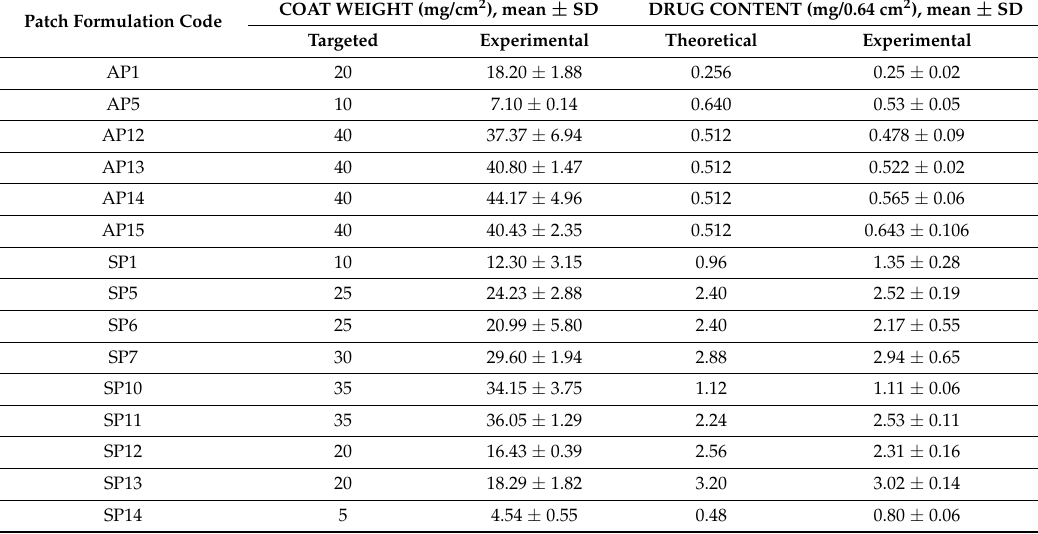
Table 3. Coat weight and drug content of TAF